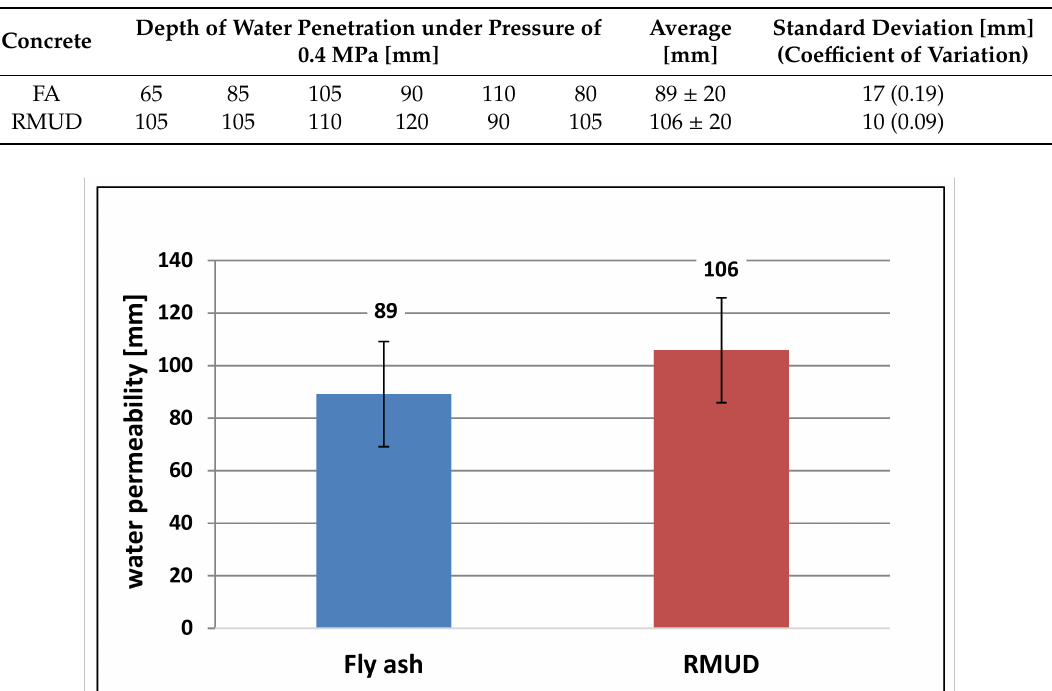
Table 5. Water permeability through concrete.